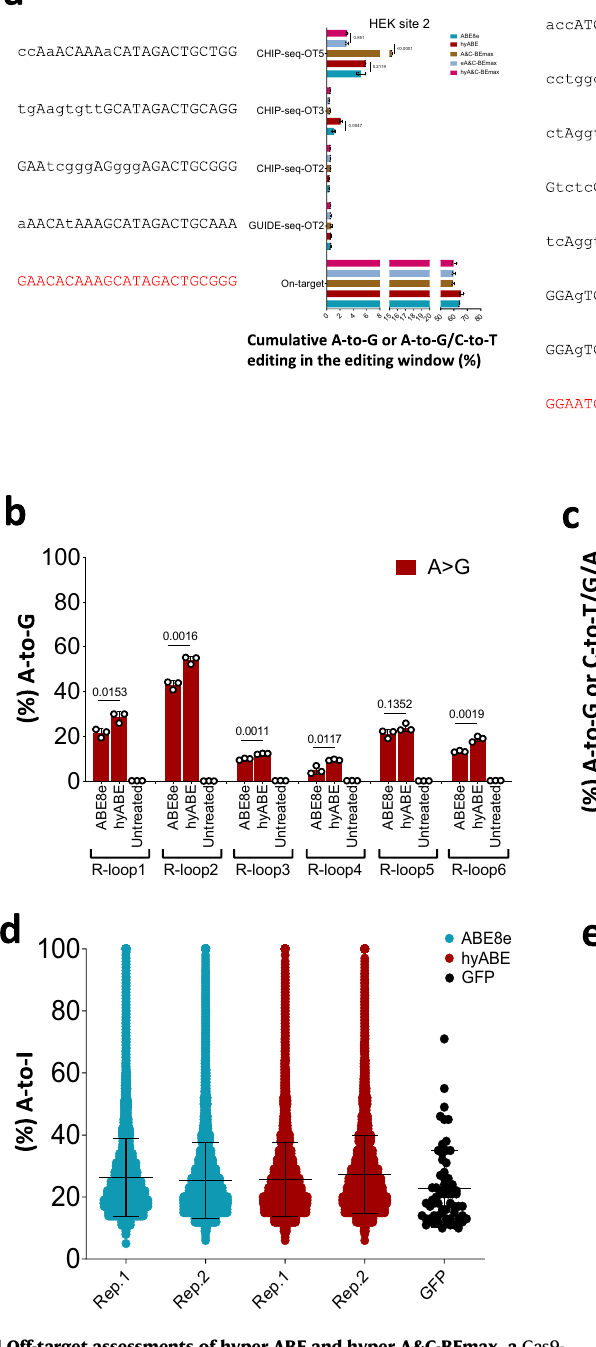
ABE8e, hyABE, A&C-BEmax, eA&C-BEmax, and hyA&C-BEmax using the modi fi ed orthogonal R-loop assay at each R-loop site with nSaCas9-sgRNA. Data are means±SD( n =3independentexperiments). d , e RNAoff-targeteditingactivityby ABE8e, hyABE, A&C-BEmax, eA&C-BEmax and hyA&C-BEmax using RNA-seq. Each biologicalreplicateislistedonthebottom.For a – c ,signi fi cancewastestedbytwo- tailed Student ’ s t test. Source data are provided as a Source Data fi